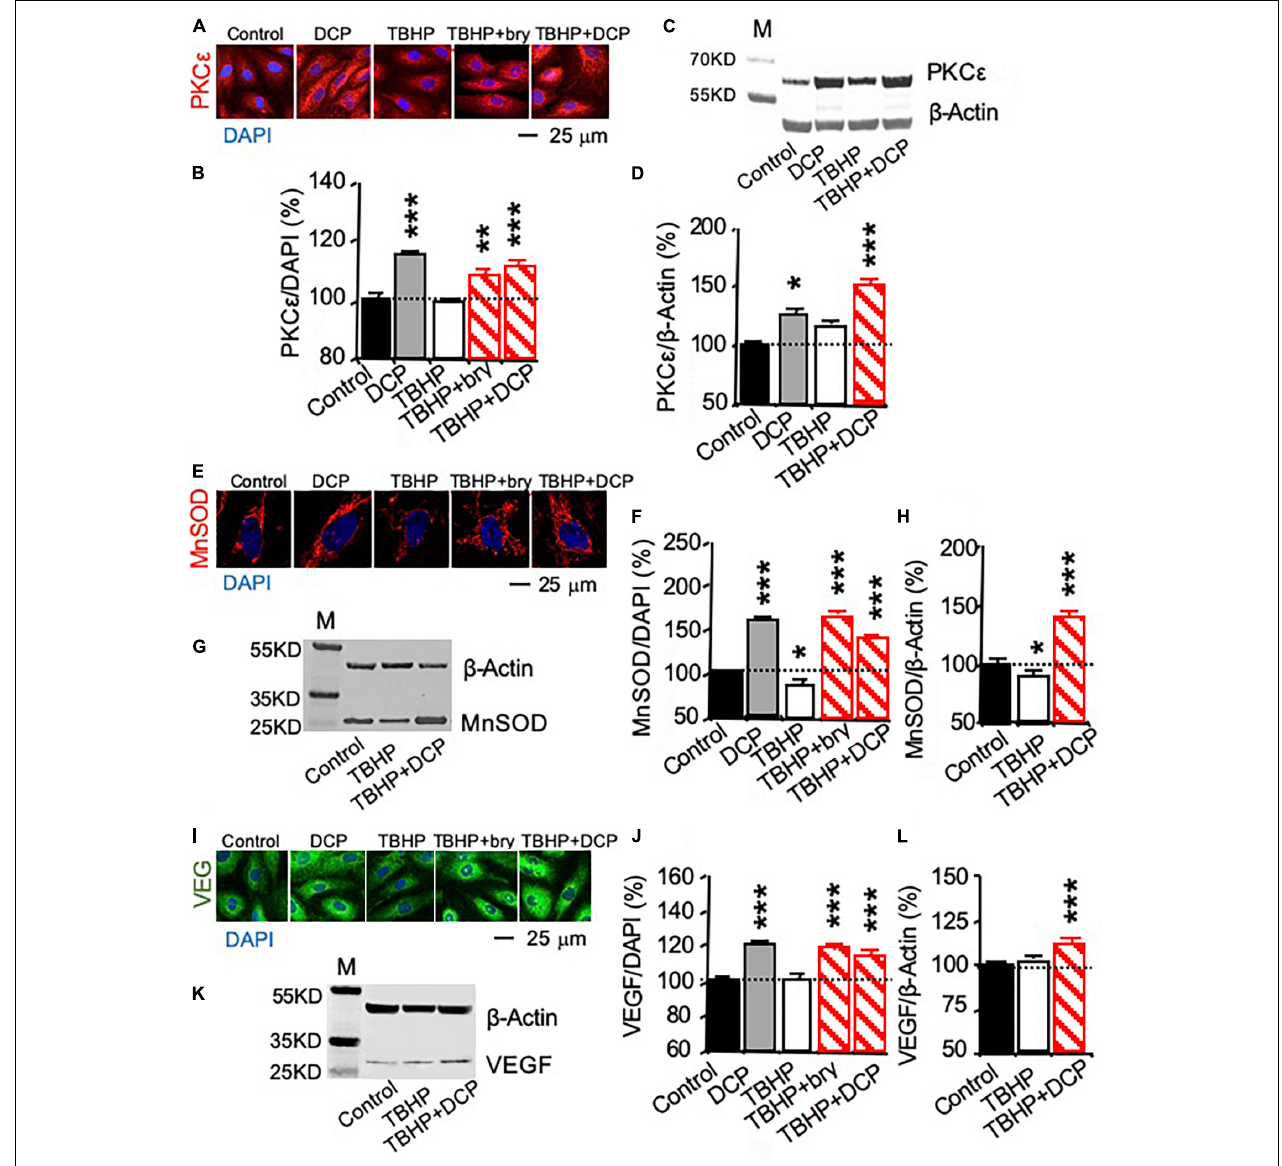
FIGURE 2 | PKC ε activation increases PKC ε , MnSOD, and VEGF protein expression in cultured human brain microvascular endothelial cells (HBMEC) treated with tert-butyl hydroperoxide (TBHP). Cultured cells were treated with 500 µ M TBHP for 1 h and incubated in new culture medium with or without the PKC ε activators bryostatin (bry, 25 nM) and DCPLA-ME (DCP, 100 nM) for 3 days. (A,B,E,F,I,J) Immunohistochemistry imaged with confocal microscopy and (C,D,G,H,K,L) western blot analysis of (A–D) PKC ε , (E–H) MnSOD, and (I–L) VEGF. M, molecular weight marker. Data are represented as mean ± SEM, * p < 0.05; ** p < 0.01; *** p < 0.001; one-way ANOVA and post hoc Tukey’s multiple comparison test ( n = 59–134 MnSOD-immunostained cells or 451–907 PKC ε or VEGF-immunostained cells from 3 to 4 cultures/group or t-test (n = 3 cultures/western blot